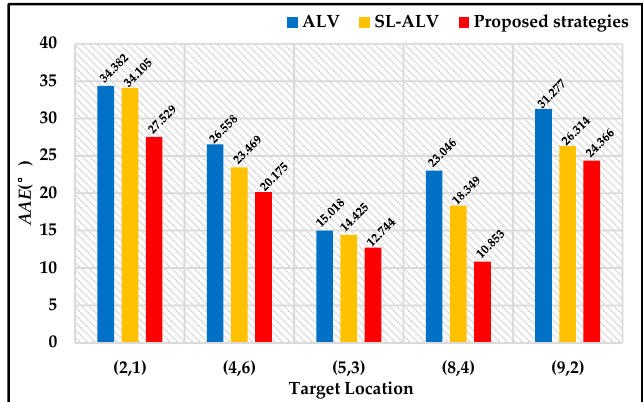
Figure 12. AAE results for ALV, SL-ALV and proposed strategies. The blue histograms denote the original ALV algorithm. The original histograms denote SL-ALV. The red histograms denote the proposed strategies.